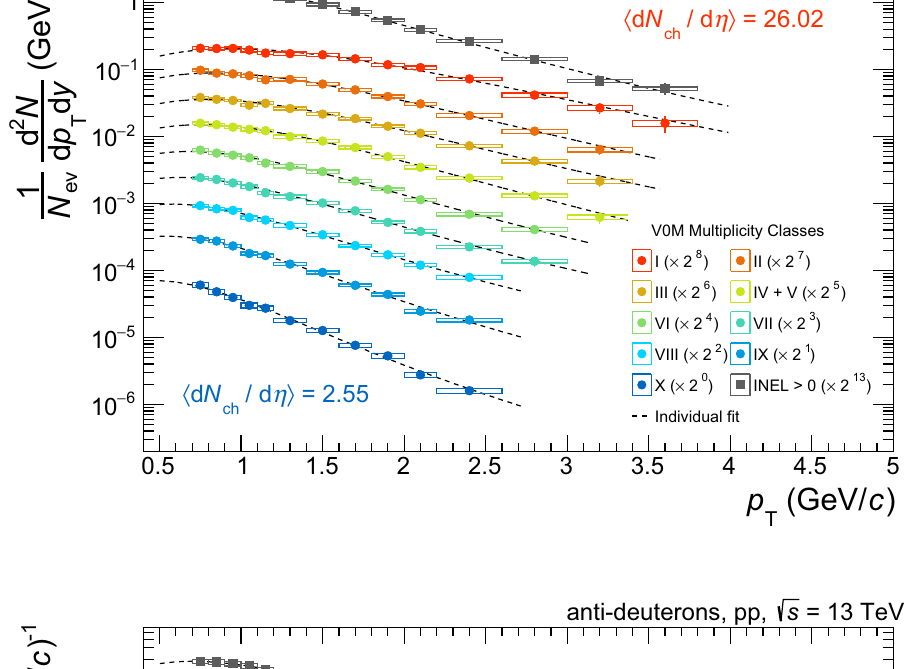
= 13 TeV s deuterons, pp, = 26.02 〉 η / d N d ch